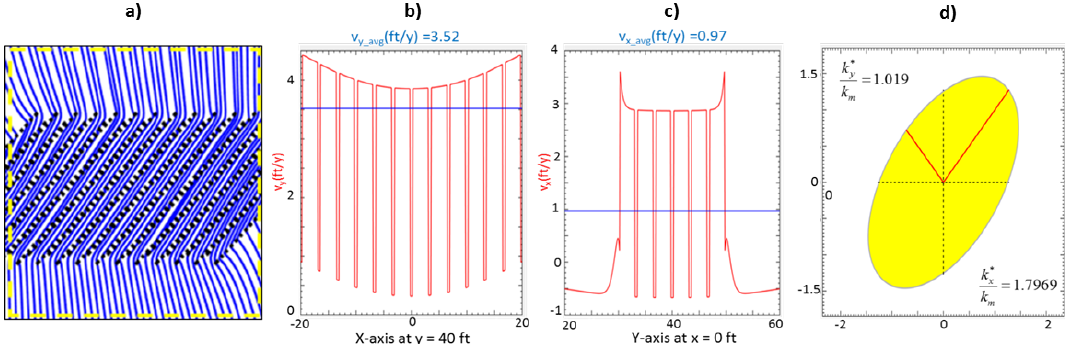
Figure A4. ( a ) Flow in a defined REV space with streamlines in blue and natural fractures (NF) in dashed black, ( b , c ) Velocity profiles along cross-hairs at y = + 40 and x = 0 respectively, ( d ) Equivalent permeability ellipse based on Equations (A13) and (A14). Number of NF = 16; width of NF = 2ft; strength of NF = 120 ft 4 /year.